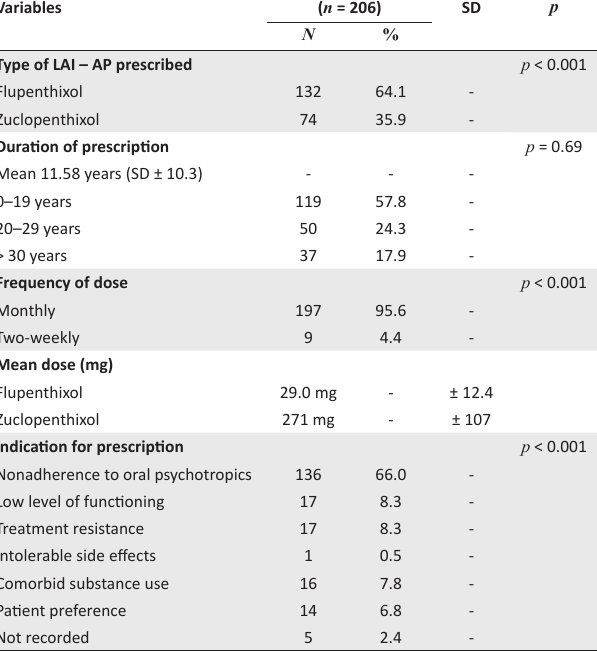
TABLE 2: Treatment characteristics of the study population.